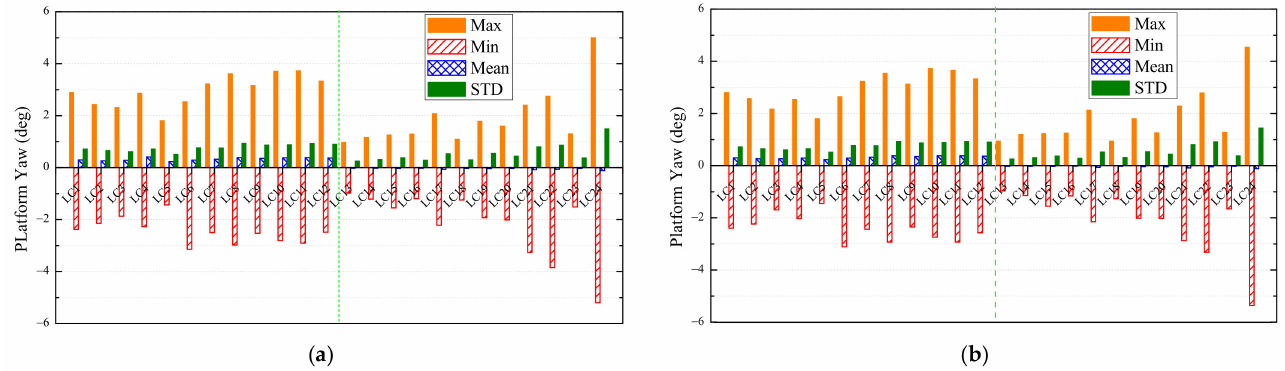
Figure 16. Statistics of platform yaw motion response for ( a ) without current; ( b ) with